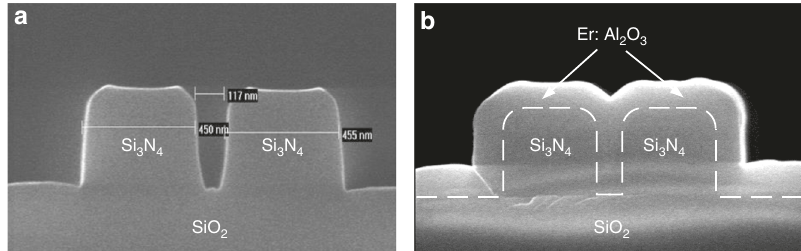
Fig. 3 Cross-sections of the fabricated slot waveguides. Silicon nitride slot waveguide with slot width of ~100 nm and strip size of ~460 × 460 nm 2 ( a ) before and b after the Er:Al 2 O 3 deposition. Cross-sections were measured with scanning electron microscopy